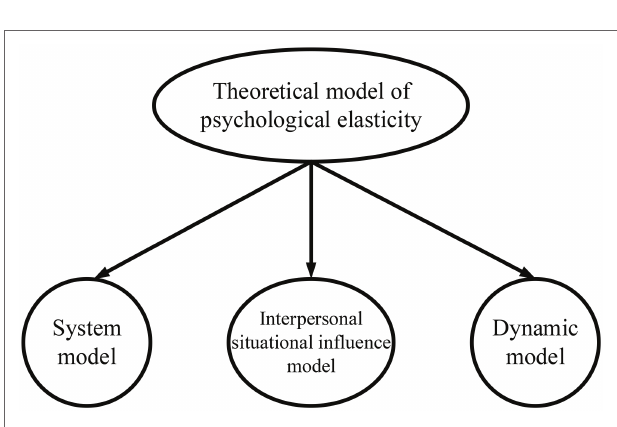
FIGURE 2 | Theoretical model of